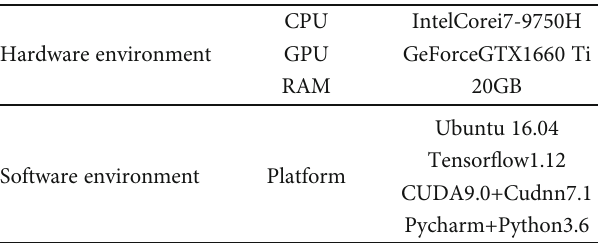
Figure 3: Labeling the fi rst arrival. (a) Microseismic signal pro fi le. (b) The fi fth signal in the pro fi Table 1: Experimental platform parameters.